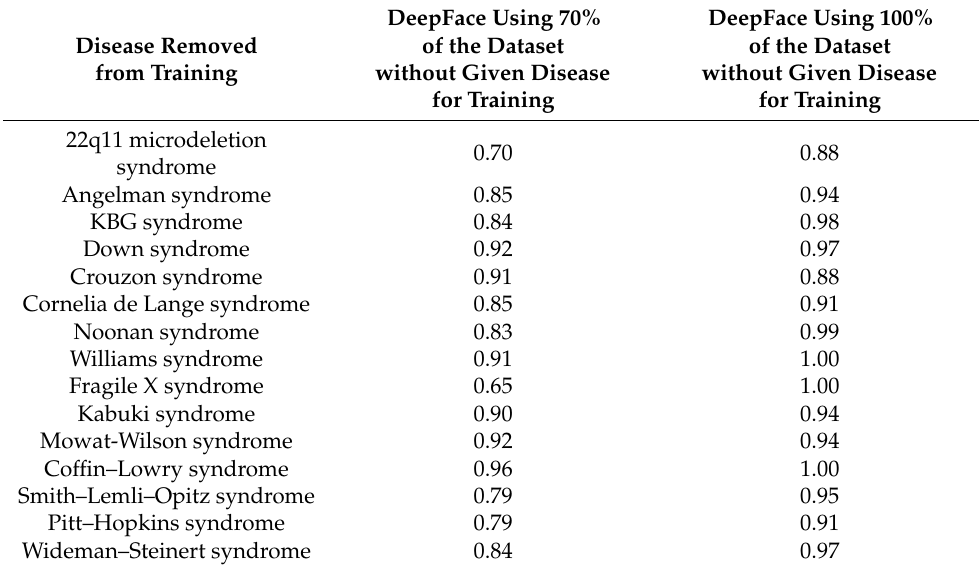
Table 4. Two class classification results for test sets of patients with diseases that were removed from the training